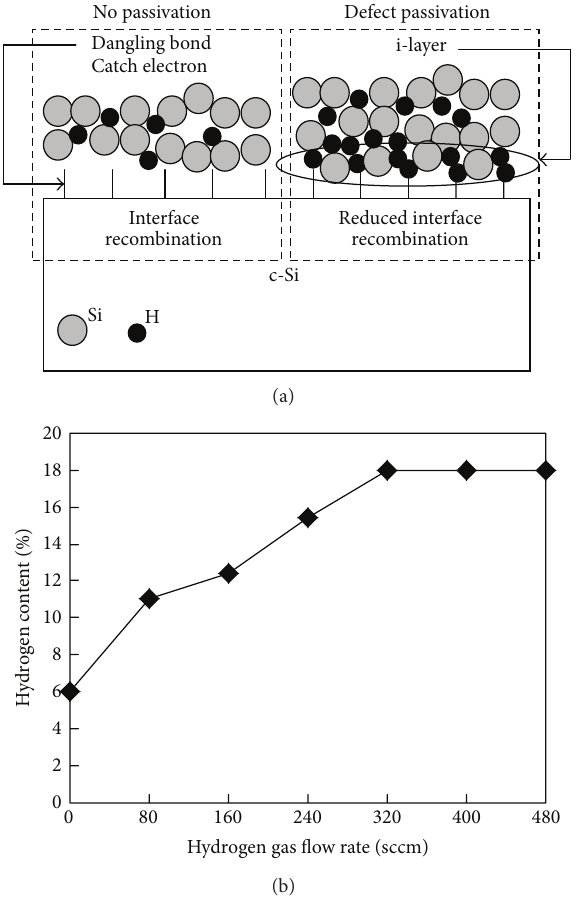
Figure 1: (a) Scheme of the mechanism of surface passivation on c-Si. (b) The relationship between hydrogen flow rate and i-layer hydrogen content.